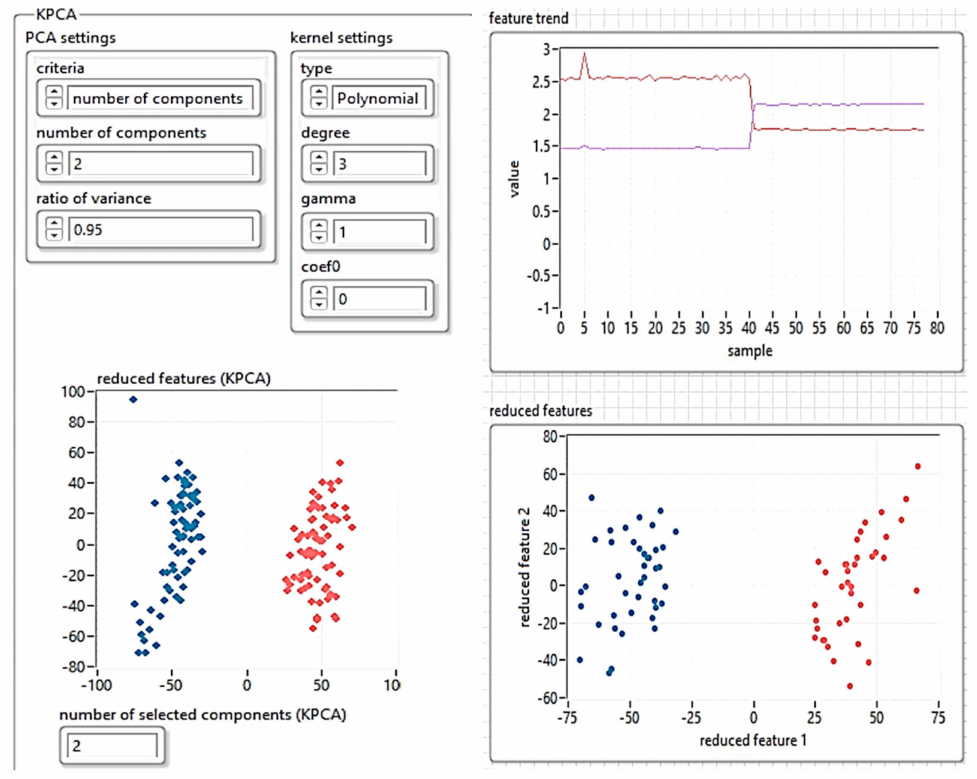
Figure 26. Feature manipulation reducing the database size using the KPCA